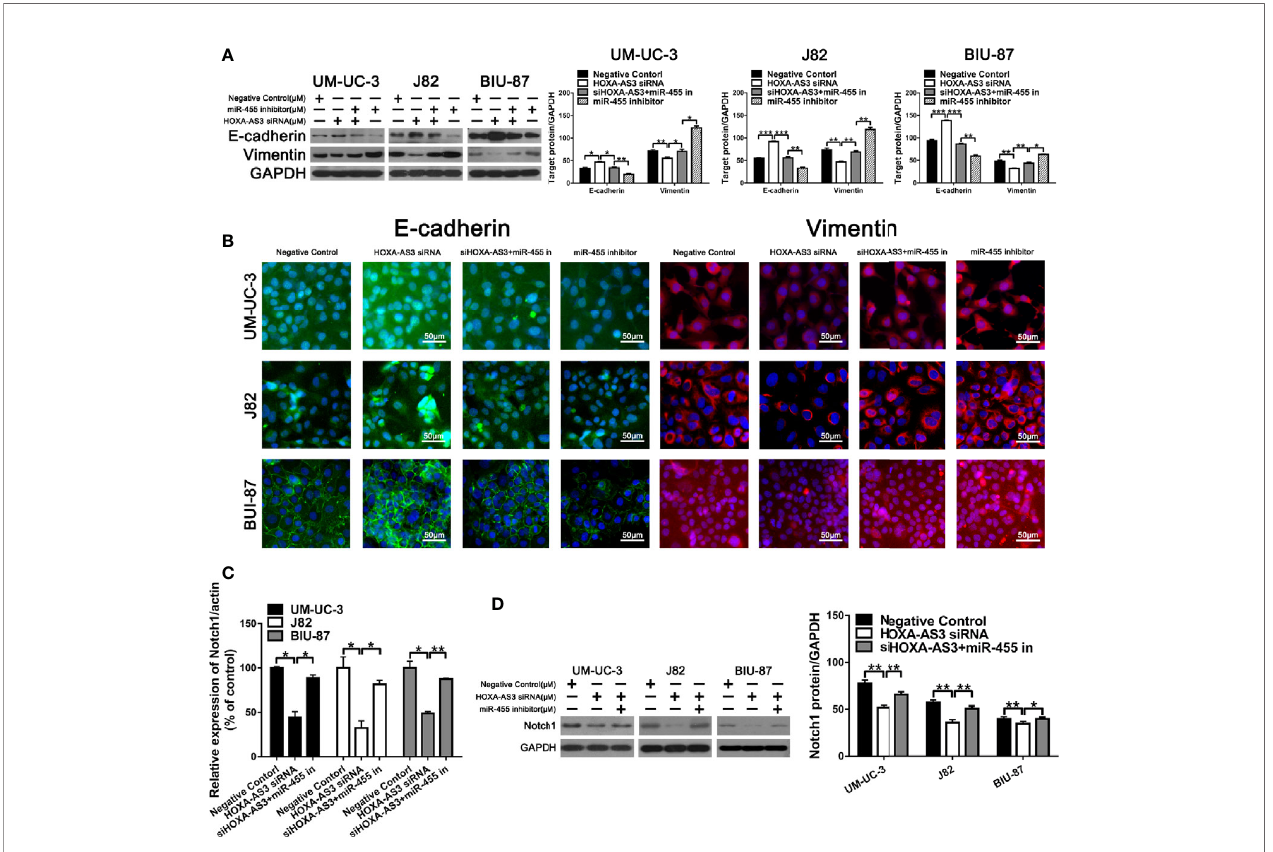
FIGURE 6 | HOXA-AS3 small interfering RNA (siRNA) reversed miR-455-5p-induced EMT. (A) Western blot analysis of the expression of EMT-related proteins. *P < 0.05, **P < 0.01, ***P < 0.001. (B) Immuno fl uorescence analysis of E-cadherin and vimentin expression in bladder cancer cells transfected with a negative control, HOXA-AS3 siRNA, miR-455-5p inhibitor, or HOXA-AS3 siRNA combined with miR-455-5p inhibitor, followed by cisplatin treatment. (C) Quantitative RT-PCR analysis of Notch1 expression following treatment with HOXA-AS3 siRNA alone, HOXA-AS3 siRNA plus miR-455-5p inhibitor, or the negative control. *P < 0.05, **P < 0.01. (D) Western blot analysis of the expression of Notch1 following treatment with HOXA-AS3 siRNA alone, HOXA-AS3 siRNA plus miR-455-5p inhibitor, or the negative control. *P < 0.05, **P <